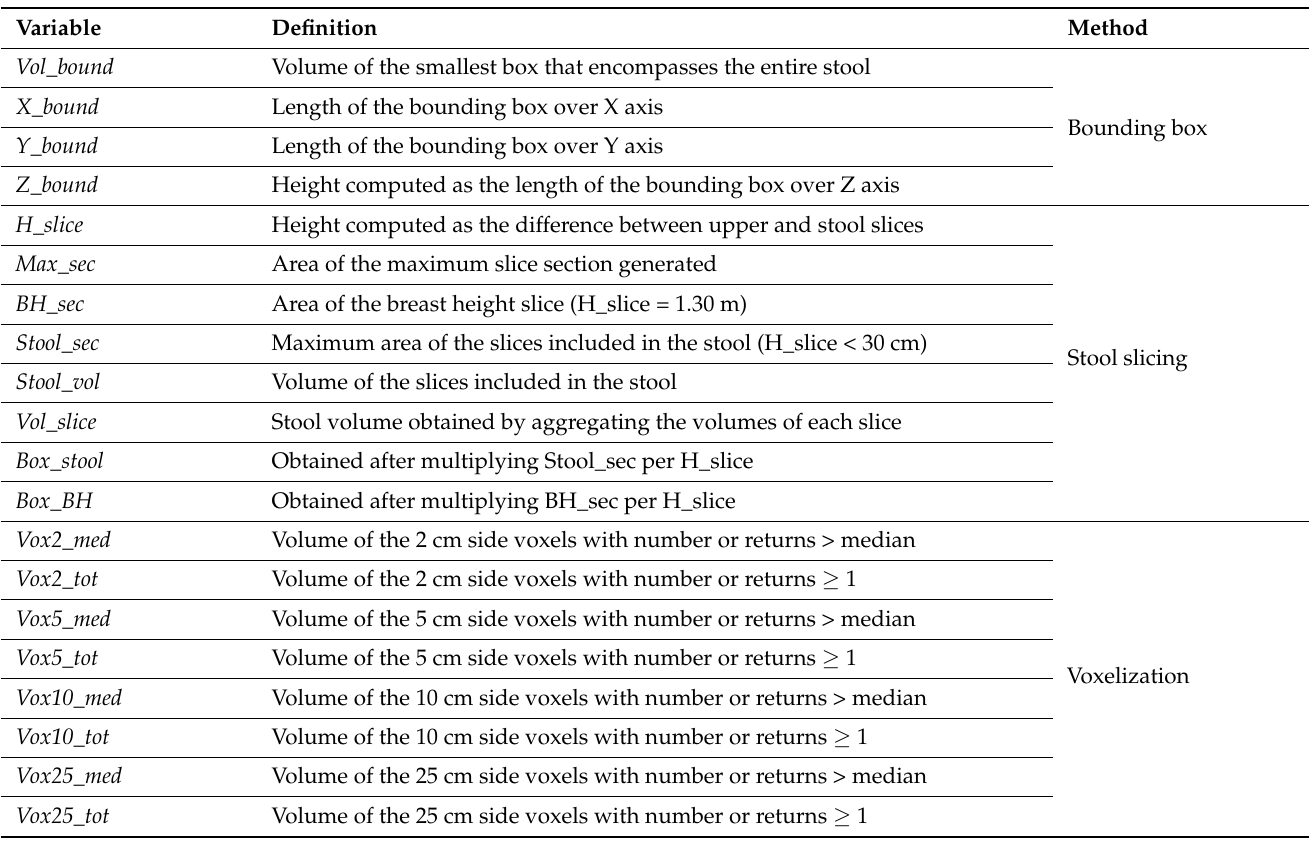
Table 1. Definition of the individual stool metrics derived from the different TLS methods.